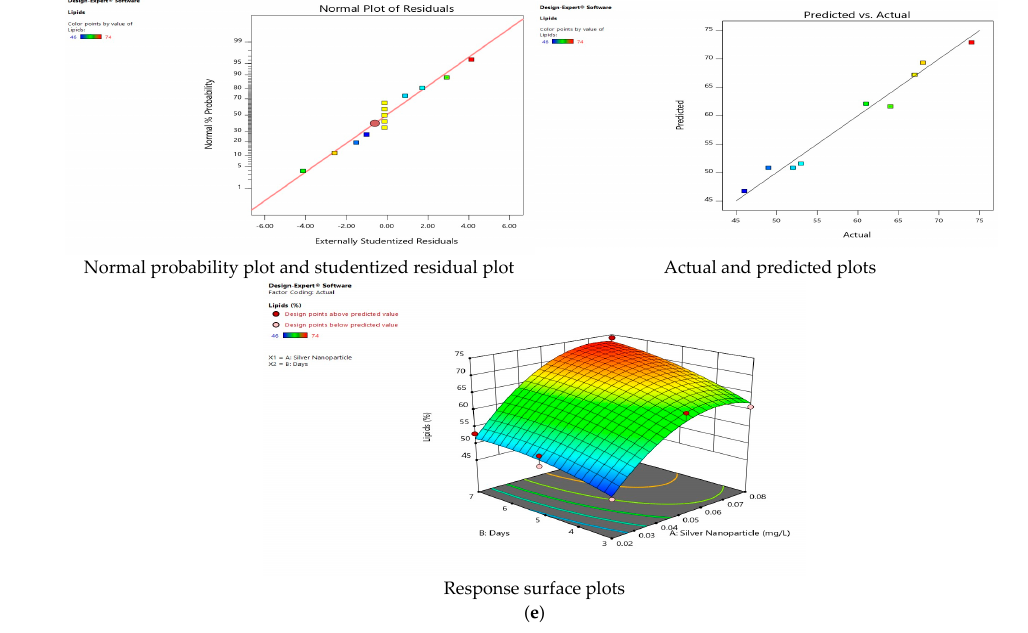
Figure 1. Response surface plots of ( a ) growth, ( b ) carbohydrates, ( c ) proteins, ( d ) chlorophyll and ( e ) lipids in Oedogonium sp. Color based on response value, as blue color shows the minimum points and red color shows the maximum points, pink color indicates points below predicted value.